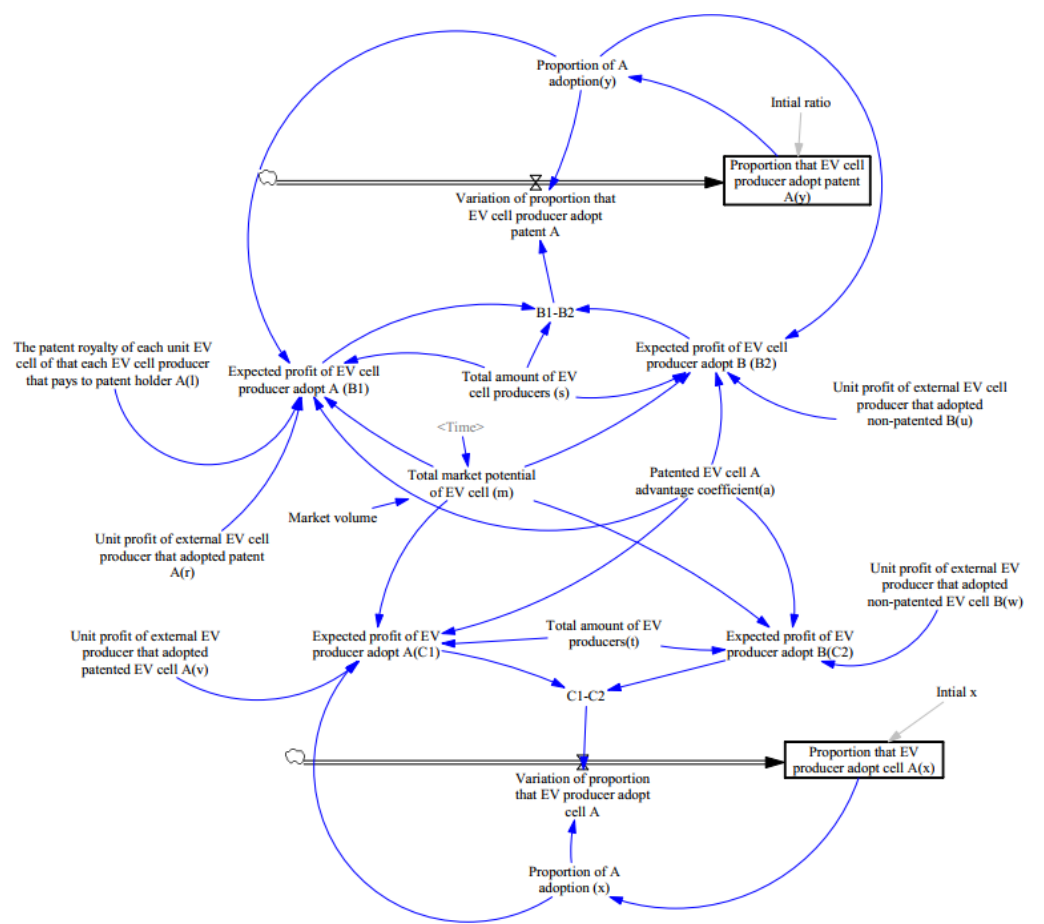
Figure 2. Dynamic system simulation diagram.